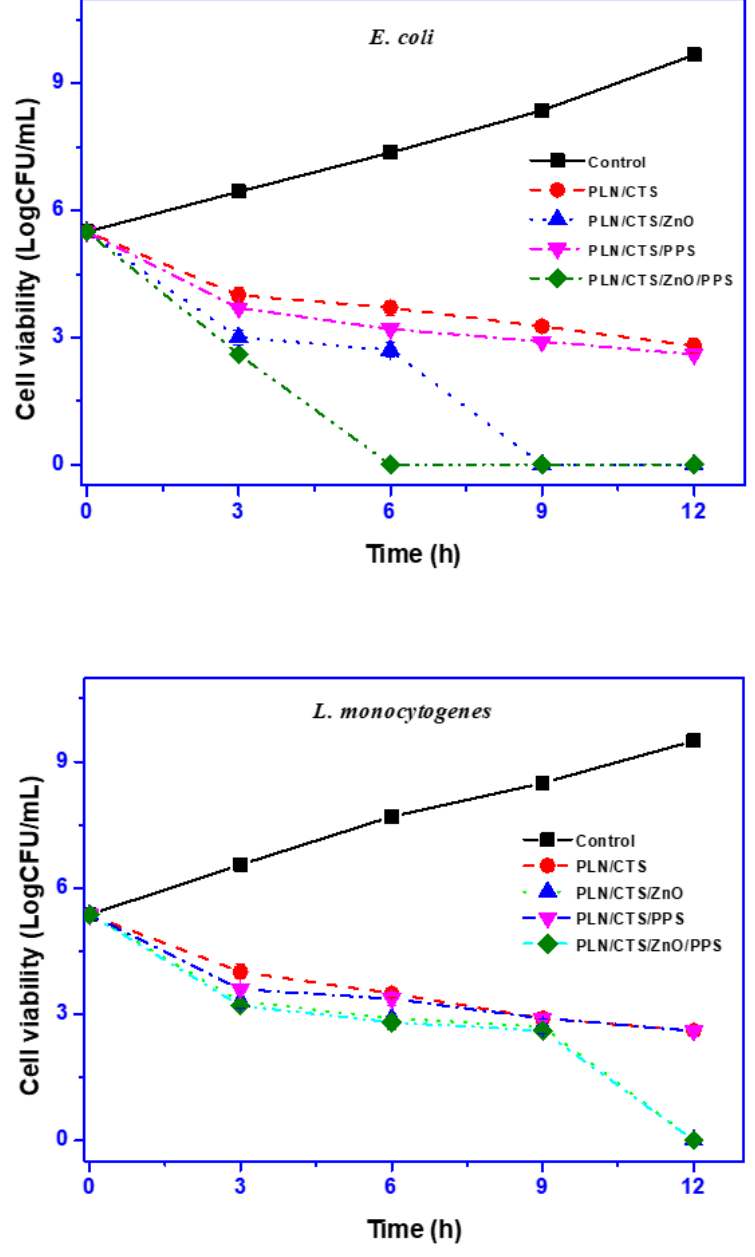
Figure 5. Antimicrobial activity of pullulan/chitosan-based composite films.